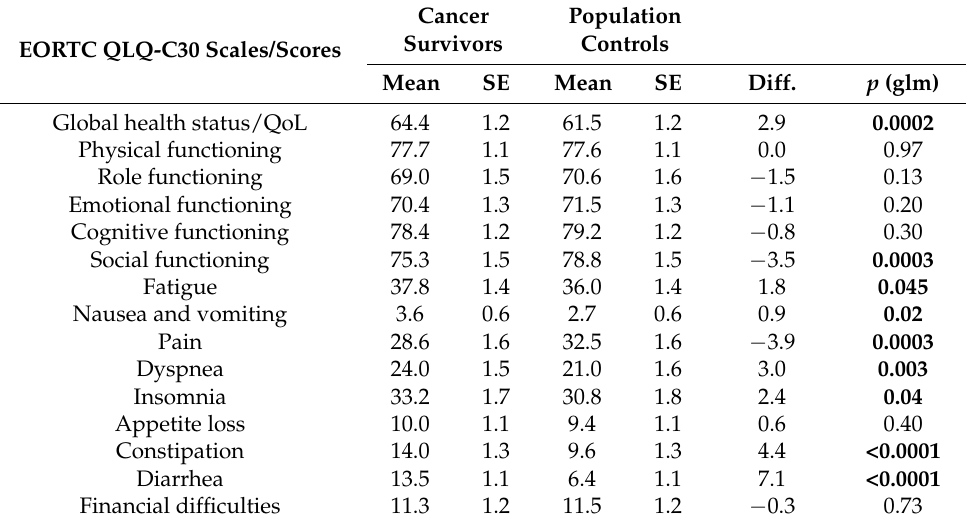
Table 3. Health-related quality of life of very long-term cancer survivors and population controls, adjusted for age, sex, and education.